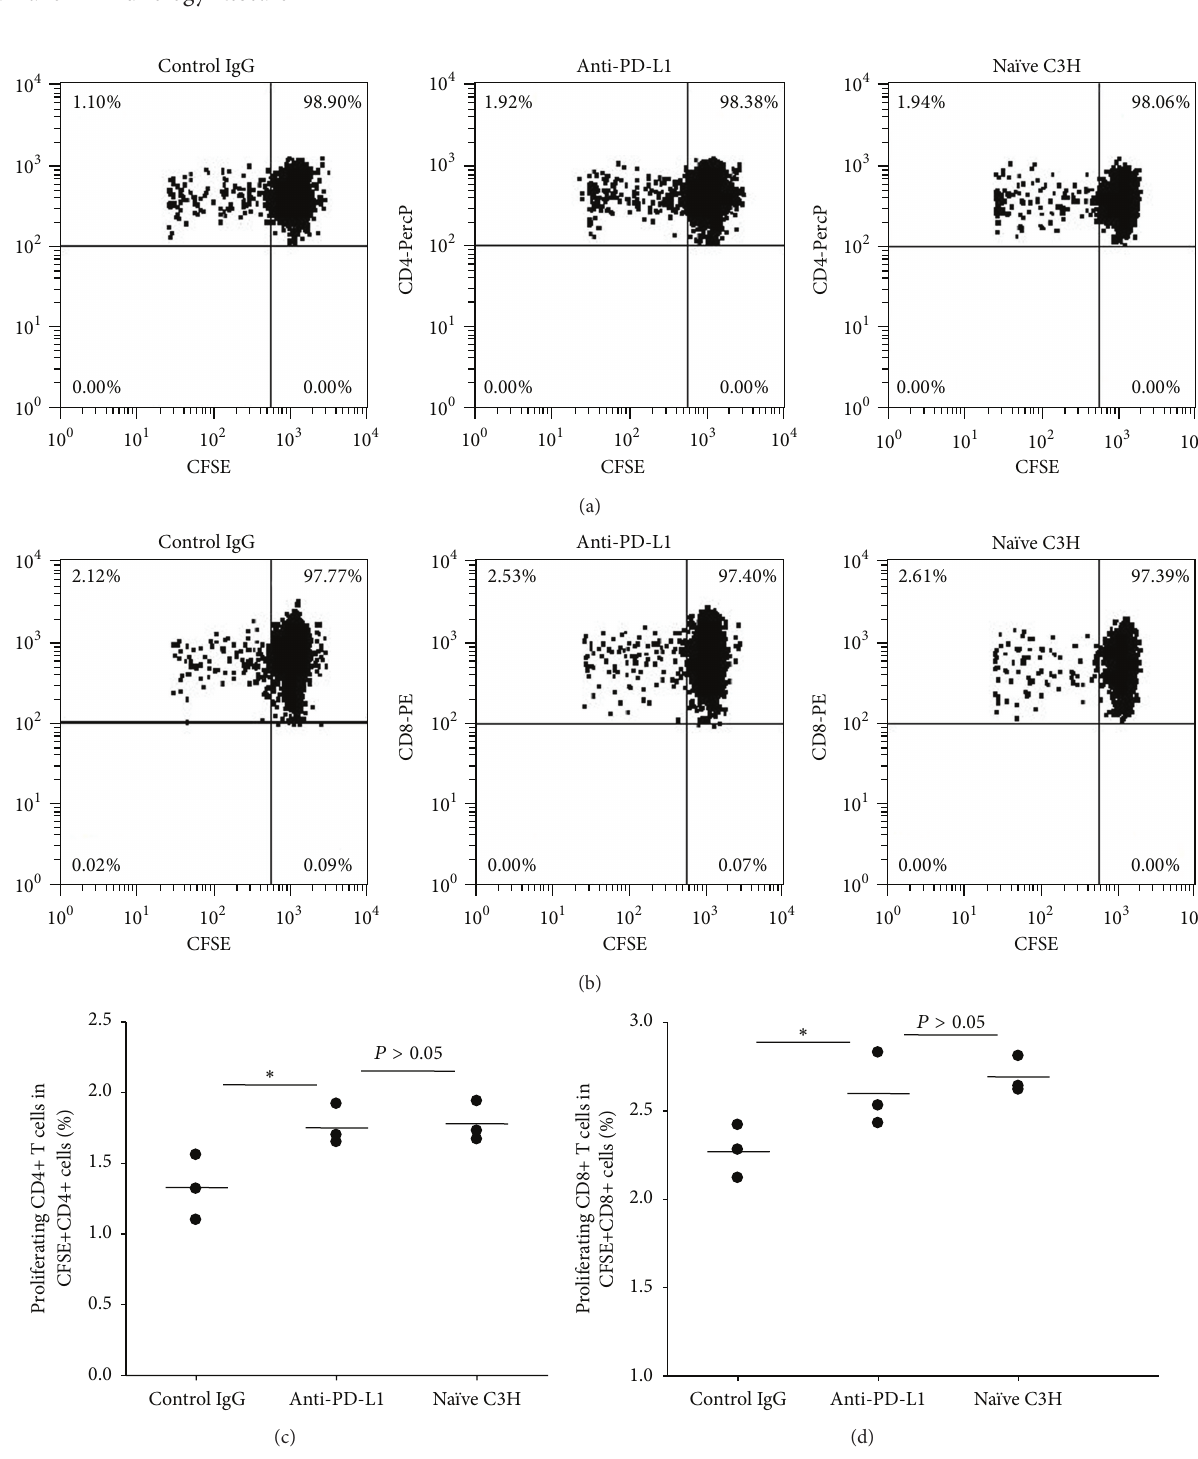
Figure 6: PD-1/PD-L1 interaction controls alloantigen-responding effector T cells in tolerant mice. C3H mice were treated with Balb/c UVB- iDCs to induce alloantigen tolerance as described elsewhere. Six weeks later, CFSE-labeled na¨ıve C3H spleen cells (1 × 10 7 /mouse) together with Balb/c spleen cells (1 × 10 7 /mouse) were intravenously injected into the tolerant mice. One group received intraperitoneal injection of anti-mouse PD-L1 mAb (100 𝜇 g/mouse); the other group received control IgG (100 𝜇 g/mouse) at the same day when cells were injected. On day 3, the above treatments were administered again. One group of na¨ıve C3H mice was set up only receiving injection of both types of cells. On day 4 after cell injection, all mice were sacrificed and inguinal lymph nodes were collected and prepared for cell suspension. The proliferating CD4+ T cells and CD8+ T cells in CFSE+ lymph node cells were analyzed by flow cytometry. (a) Representative flow cytometric data on CFSE-labeled CD4+ T cell proliferation in each group were shown; (b) representative flow cytometric data on CFSE-labeled CD8+ T cell proliferation in each group were shown; ((c) and (d)) the summary of CD4+ and CD8+ T cell proliferation was shown, respectively. Data represent mean ± standard error. ∗ 𝑃 < 0.05 . The 𝑃 values were calculated using one-way